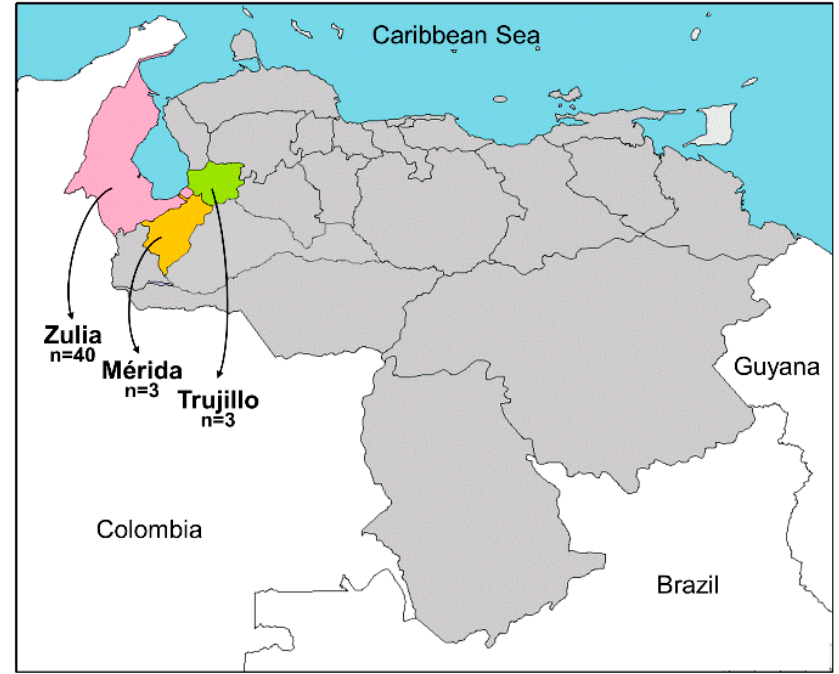
Figure 1. Map of Venezuela showing the geographic location of the states of Zulia (pink), Mérida (orange), and Trujillo (green). The number of samples ( n ) collected in each state is indicated.